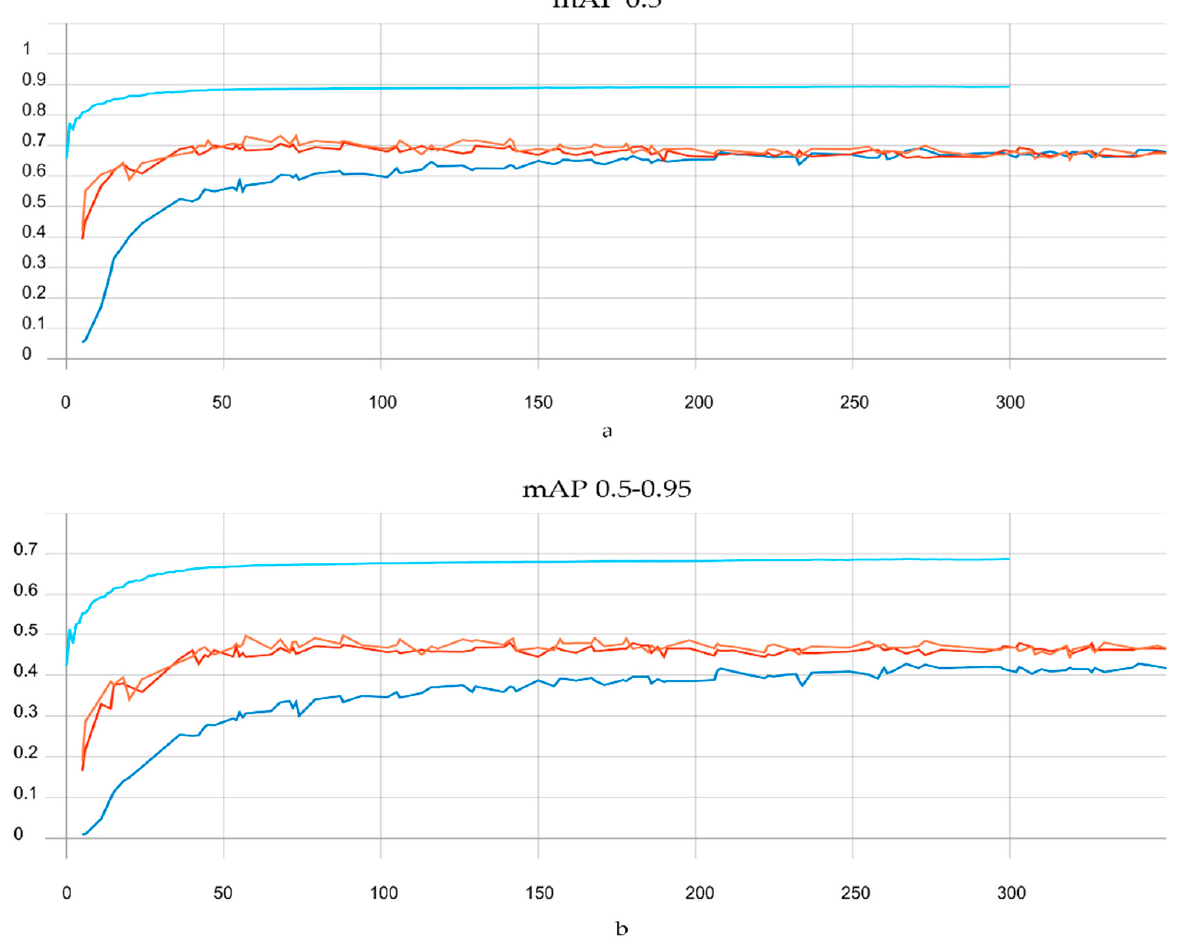
Figure 12. Performance of the four models, Scaled YOLOv4, YOLOv5l, YOLOv5s, and YOLOv5m using two metrics, mAP 0.5 ( a ) and mAP 0.5–0.95 ( b ). TensorBoard was used to create these graphics.